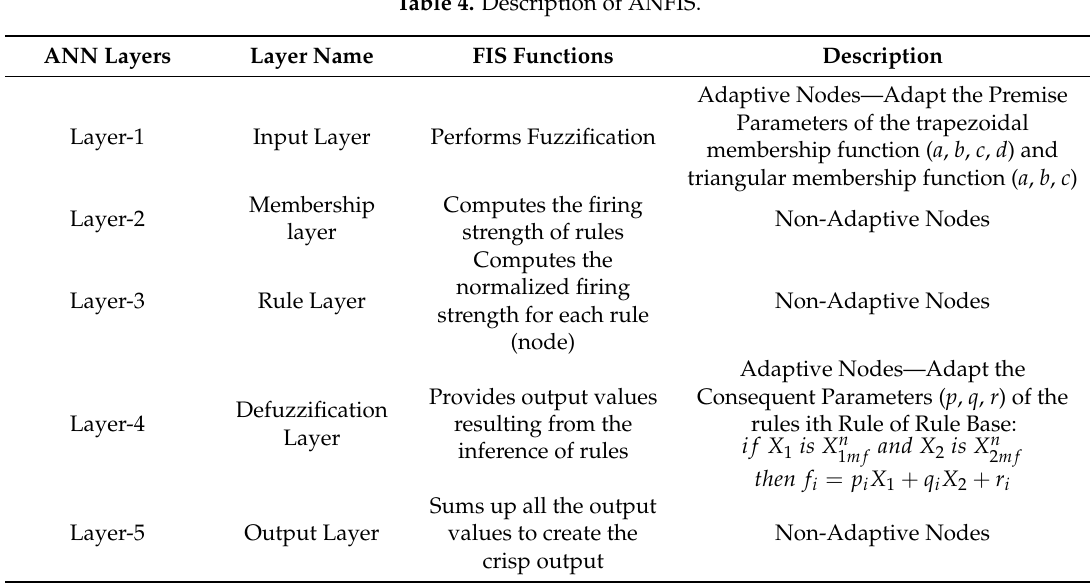
Figure 5. Architecture of ANFIS. Table 4. Description of ANFIS.